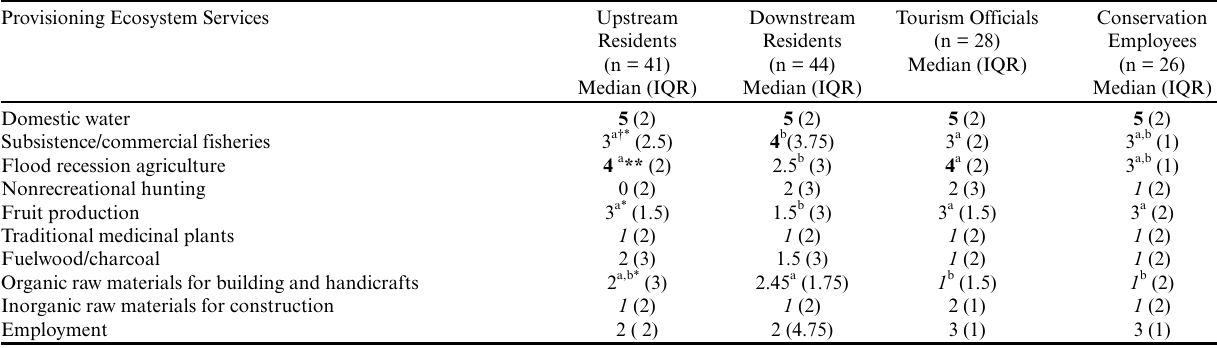
Table 3 . Relative importance of provisioning ecosystem services provided by the Wami River and Estuary as perceived by 41 upstream residents, 44 downstream residents, 28 tourism operators, and 26 conservation employees. The survey respondents distributed 25 marbles among 10 provisioning ES (expected value = 2.5). The values in the table are median (interquartile range). Those in bold and italics denote values 50% higher and lower, respectively, than the expected